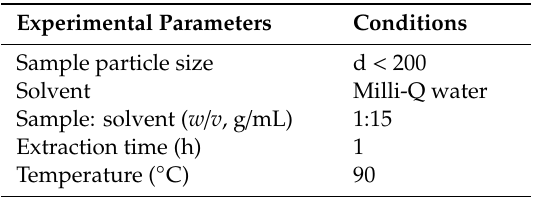
Table 5. Experimental parameters of hot water extraction.